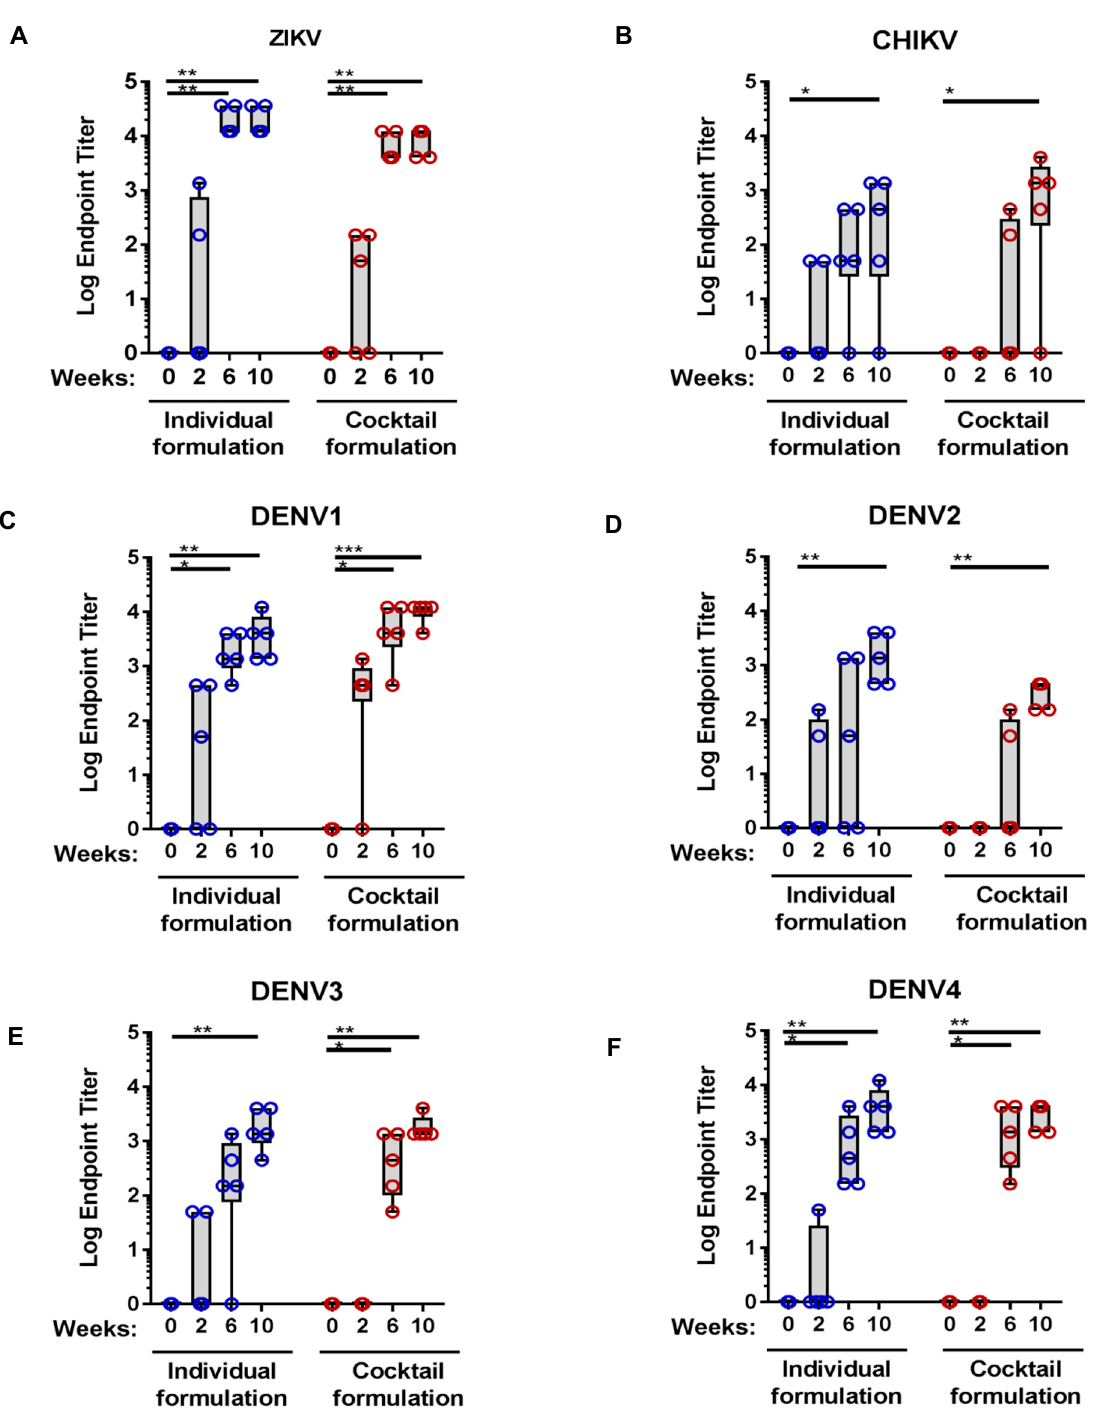
Figure 4. Humoral immune responses in NHPs after MMBV DNA vaccination via intradermal electroporation. Rhesus macaques ( n = 5/group) were immunized with pZIKV, pDENV1–4, and pCHIKV plasmids delivered by ID-EP as either a cocktail formulation into the same treatment sites or individual formulation with distinct treatment sites for each plasmid. Serum IgG EPTs for individual NHPs at the indicated timepoints were measured by binding ELISA to ZIKV ( A ), CHIKV ( B ), DENV1 ( C ), DENV2 ( D ), DENV3 ( E ), and DENV4 ( F ) envelope proteins. Data represents binding IgG endpoint titers of individual NHPs. Asterisks indicate significant difference in IgG EPTs compared to Week 0 as described in the methods. There were no significant differences between individual and cocktail formulation treatment